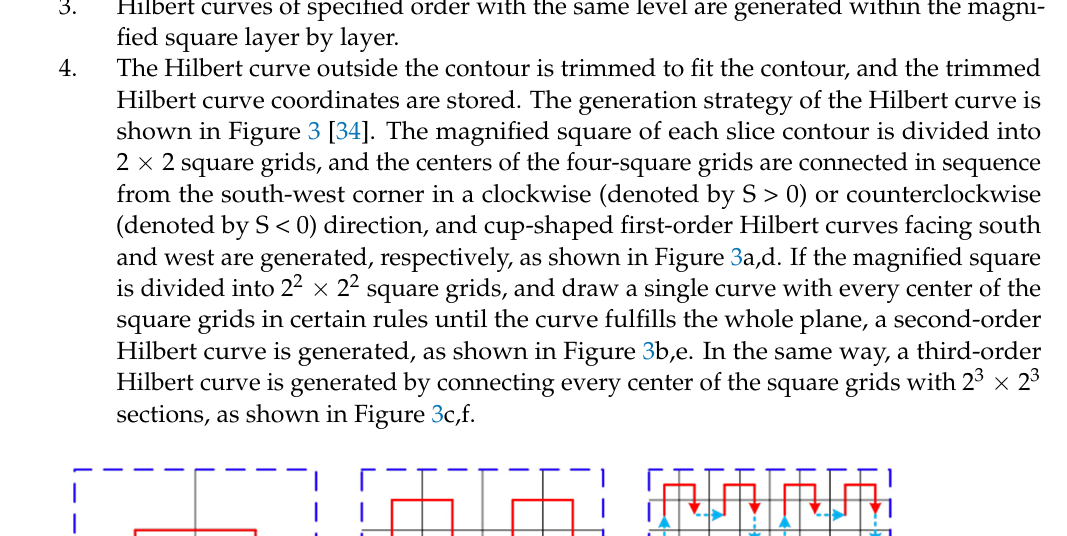
Figure 4. The side lengths of Hilbert curves with different orders ( n = 1, 2, 3 from left to right), the black solid line, and the blue dash-dotted line denote the original and magnified square, respec- tively, and the red line denotes the generated Hilbert curves. When the order of Hilbert curve n takes 2, each slice was subdivided thrice, and the infill patterns within each slice at various heights are similar, as shown in Figure 5, but the side length of the Hilbert curves decreases with decreasing cross-sectional area. When the heights of the model are 0, 25, and 40 mm, the corresponding cross-section